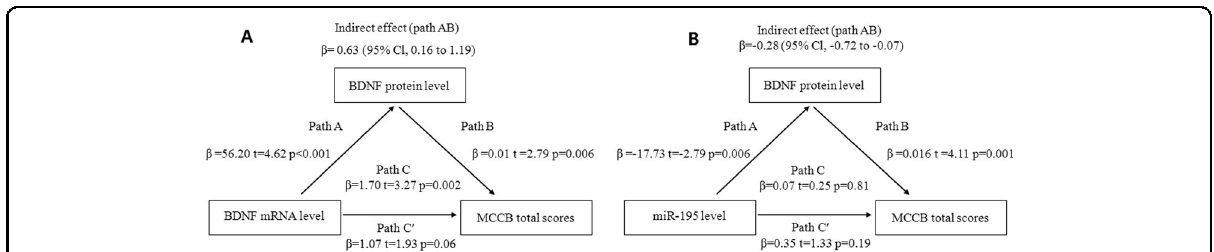
Fig. 4 BDNF protein mediated BDNF mRNA and miR-195 on cognitive performances. A Analyses were performed to study the mediated effects of BDNF mRNA on MCCB total scores via BDNF protein in the patients. Path AB is the mediation effect and is signi fi cant at P < 0.05 based on con fi dence intervals from bias-corrected bootstrapping of 2000 samples. B The same analysis using miR-195 as the